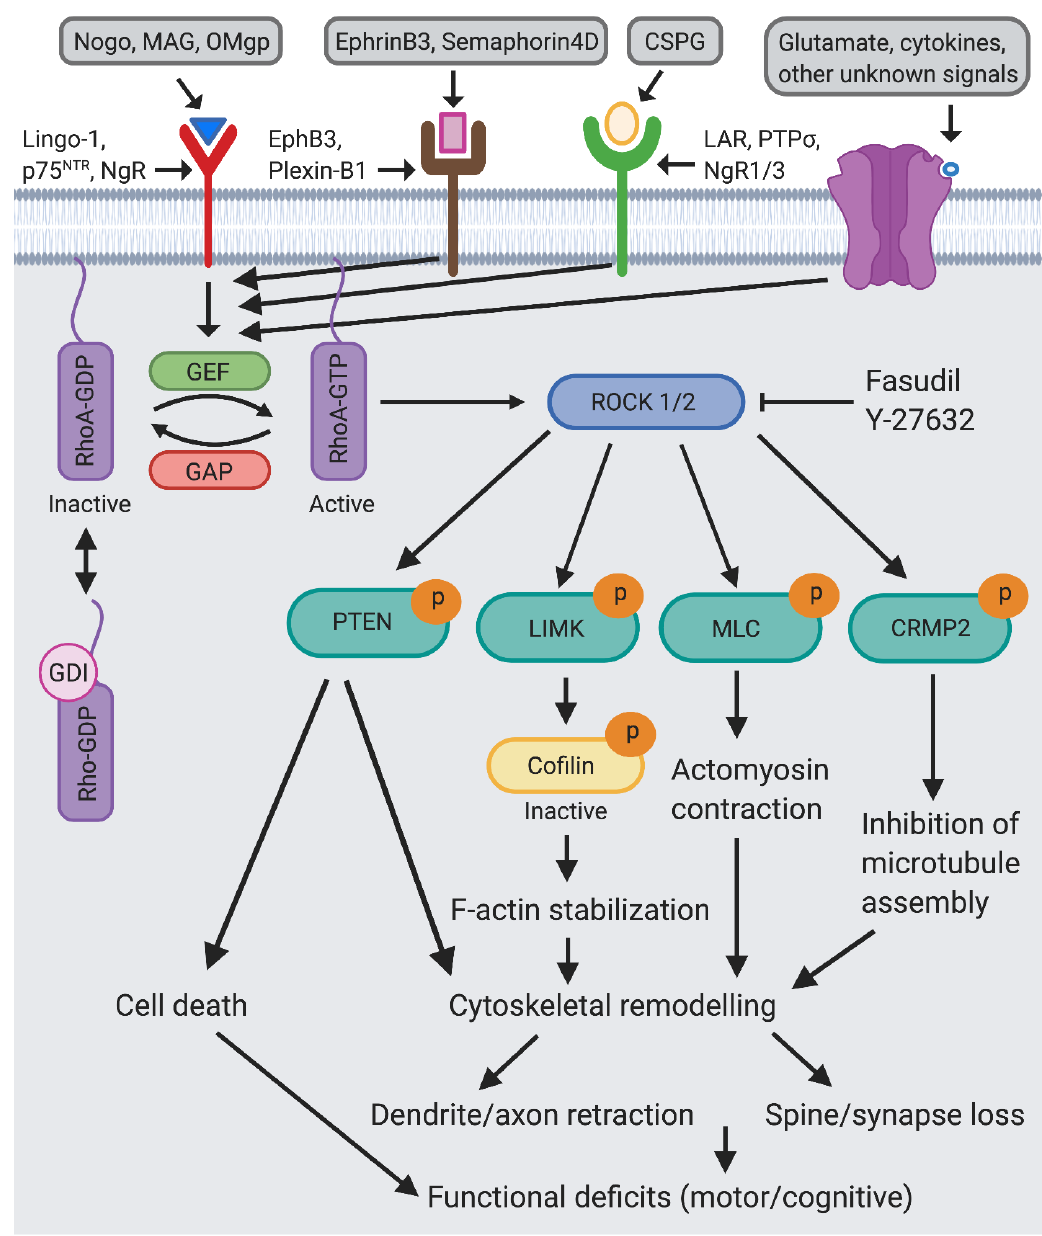
Figure 1. Model for the role of the RhoA-ROCK pathway in the pathogenesis of TBI. The small GTPase RhoA is activated by RhoA-GEFs in response to various extracellular signals triggered by injury. Active GTP-bound RhoA binds to and stimulates the activity of the serine / threonine kinase ROCK1 / 2. Through phosphorylation of downstream e ff ectors such as PTEN, LIMK, MLC, and CRMP-2, ROCK initiates signaling cascades that induce cytoskeletal remodeling underlying dendrite / axon retraction and synapse / spine loss as well as cell death, which together contribute to functional deficits. Inhibition of ROCK (e.g., Fasudil, Y-27632) or RhoA rescues these TBI-induced deficits. ROCK: Rho Kinase, GEF: guanine nucleotide exchange factor, GAP: GTPase-activating protein, GDI: Guanine nucleotide dissociation inhibitor, PTEN: phosphatase and tensin homolog, LIMK: LIM kinase, MLC: myosin light chain, CRMP2: collapsin response mediator protein 2, MAG: myelin-associated glycoprotein, OMgp: oligodendrocyte-myelin glycoprotein, NgR: nogo receptor, PTP σ : protein tyrosine phosphate σ , NgR1 / 3: nogo receptor 1 and 3, LAR: leukocyte common antigen-related phosphatase, CSPG: chondroitin sulfate